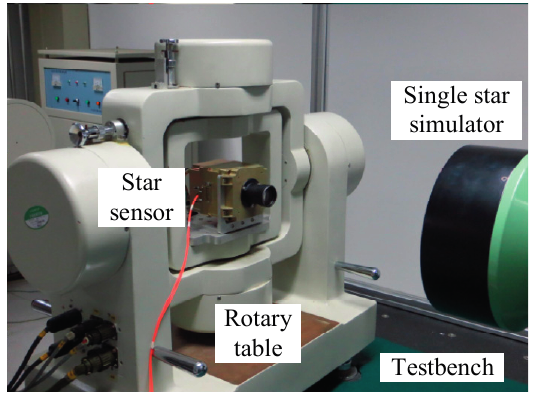
Figure 13. Laboratory calibration of the intensified star tracker.